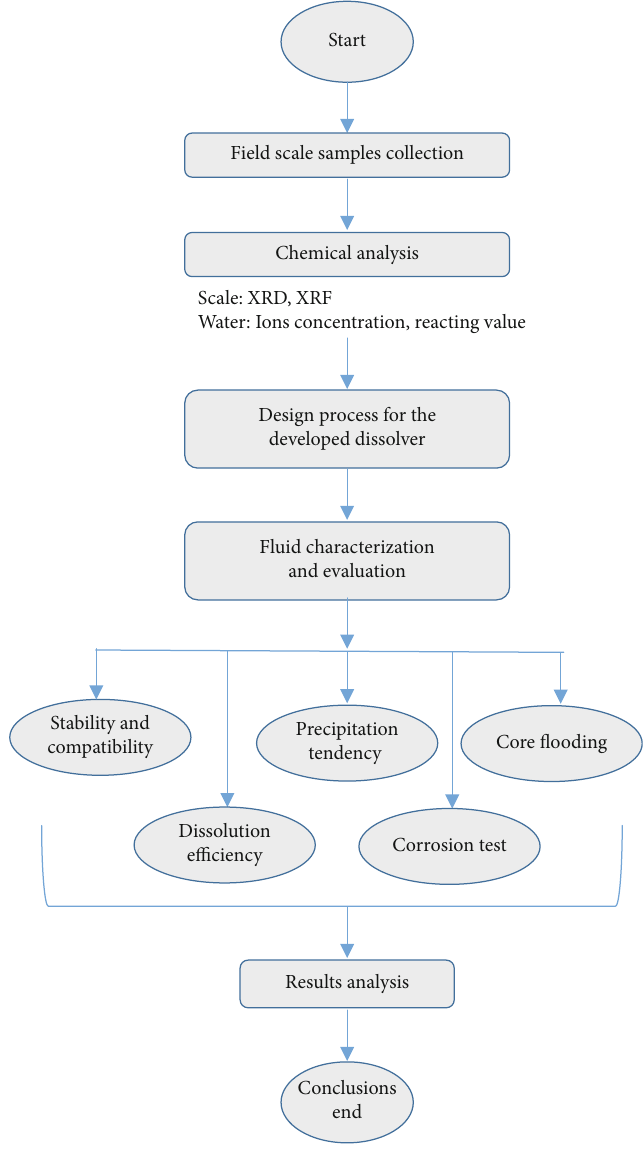
Figure 1: The methodology layout for the